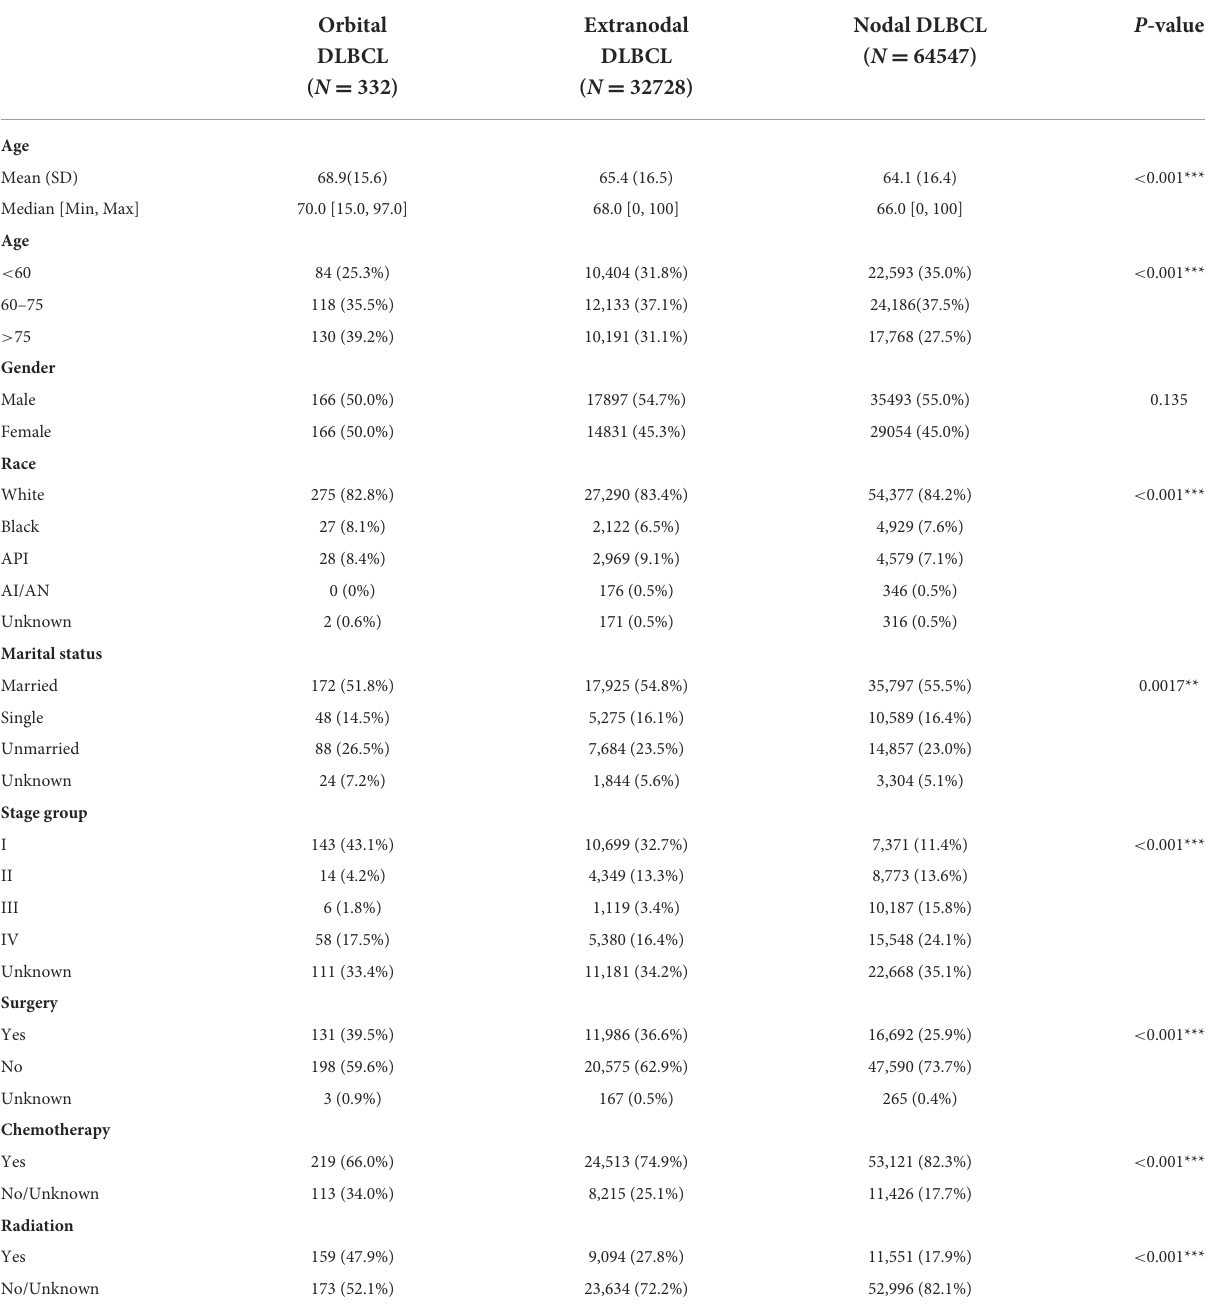
TABLE 1 Demographics and clinical features of patients with orbital DLBCL, nodal, and other extra-nodal sites as diagnosed in the SEER database